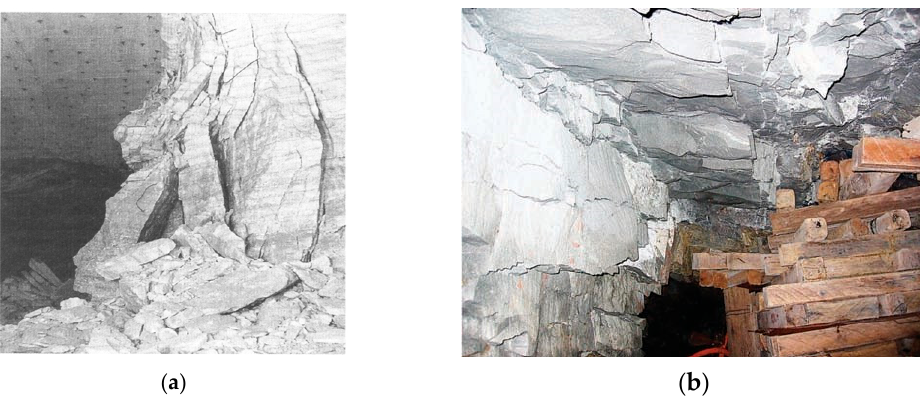
Figure 5. Sidewall spalling, floor softening, fracture extension and hangingwall falling out induced by tunnel or stope excavations. Schemes follow another format. ( a ) Wall spalling and floor softening caused by excavating drift tunnel within rock salt in Germany [36]; ( b ) Hangingwall falls out along the primary fracture extension both caused by a 3300 m deep gold mining within hard orebody Ventersdrop Contact Reef in South Africa [37].